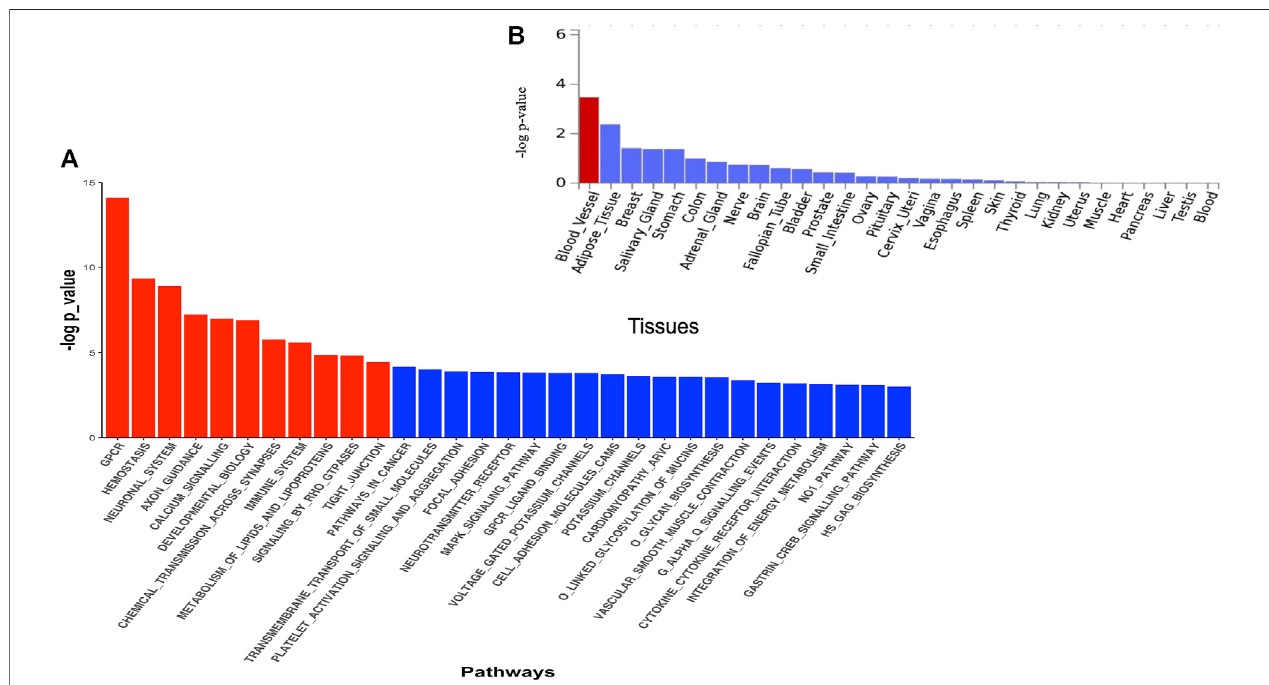
FIGURE4| (A) Pathwayscoresobtained from pascal analysis. Signi fi cantpathways at Bonferronicorrected p -value ≤ 0.05are coloured in red. (B) Tissuespeci fi c gene expression and shared biological functions of genes identi fi ed by pascal in GTEx v8 30 general tissue types. Input genes were tested against each of the precomputed differentially expressed sets using the hypergeometric test. Signi fi cant enrichment at Bonferroni corrected p -value ≤ 0.05 are coloured in